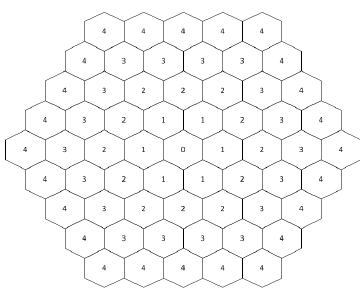
Figure 5. Distribution and number of cells in a coverage